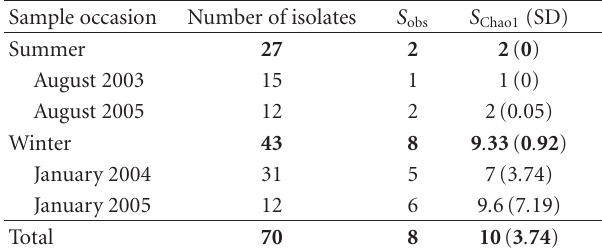
Table 1: Diversity estimates of culturable Pseudomonas popula- tions. Total and sample occasion diversity are indicated. Observed diversity in terms of total number of di ff erent lineages is indicated as S obs and nonparametric richness estimator of the actual number of lineages is indicated as S Chao1